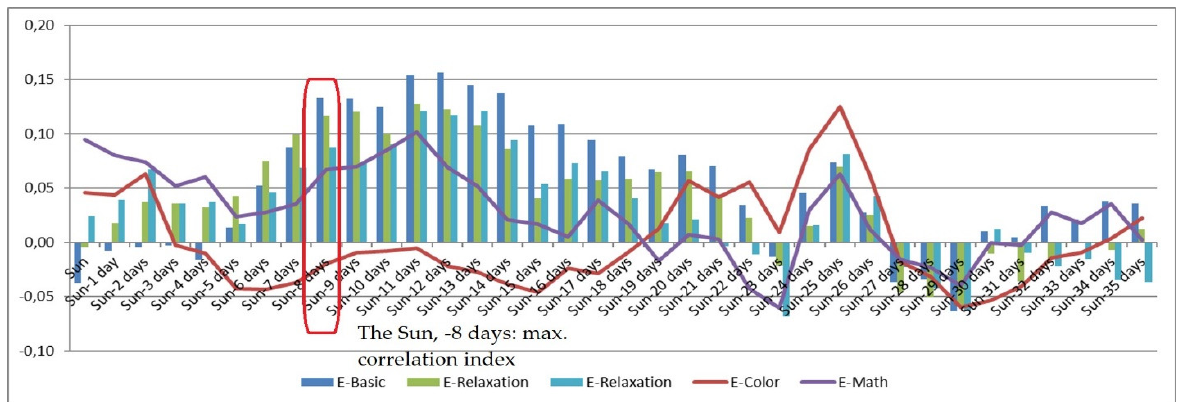
Figure 5. The correlation dependency of the psychophysiological parameter B (BVP HF % power mean) on the intensity of solar activity.